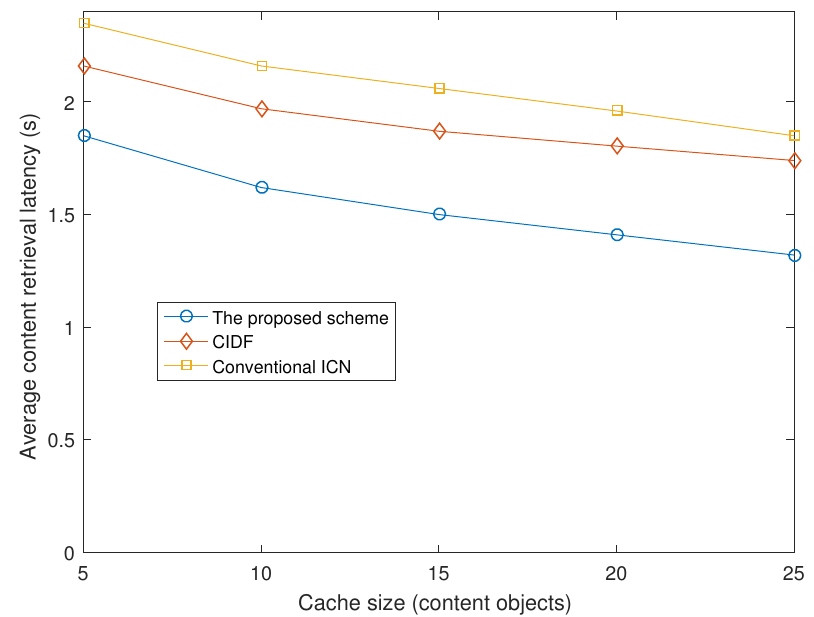
Figure 5. Average content retrieval latency vs. cache